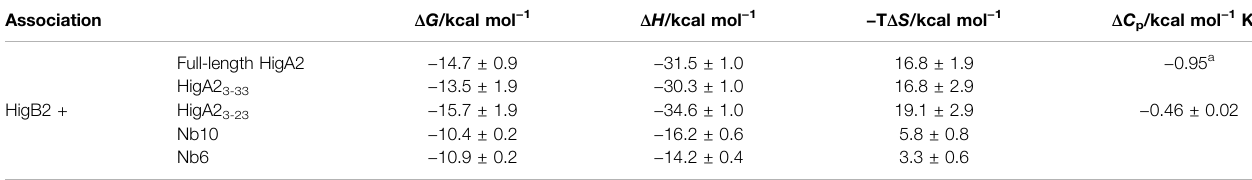
TABLE 1 | Thermodynamics of HigA2 and HigB2 association derived from the ITC experiments. Parameters are reported at T (cid:1) 25 ° C.